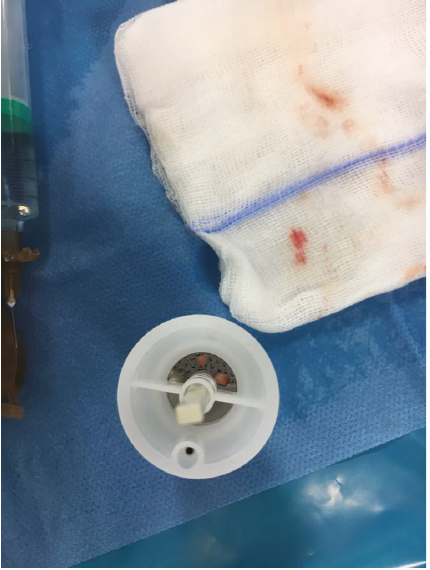
Figure 4: The disposable Rigeneracons loaded with a maximum of 3 dermal